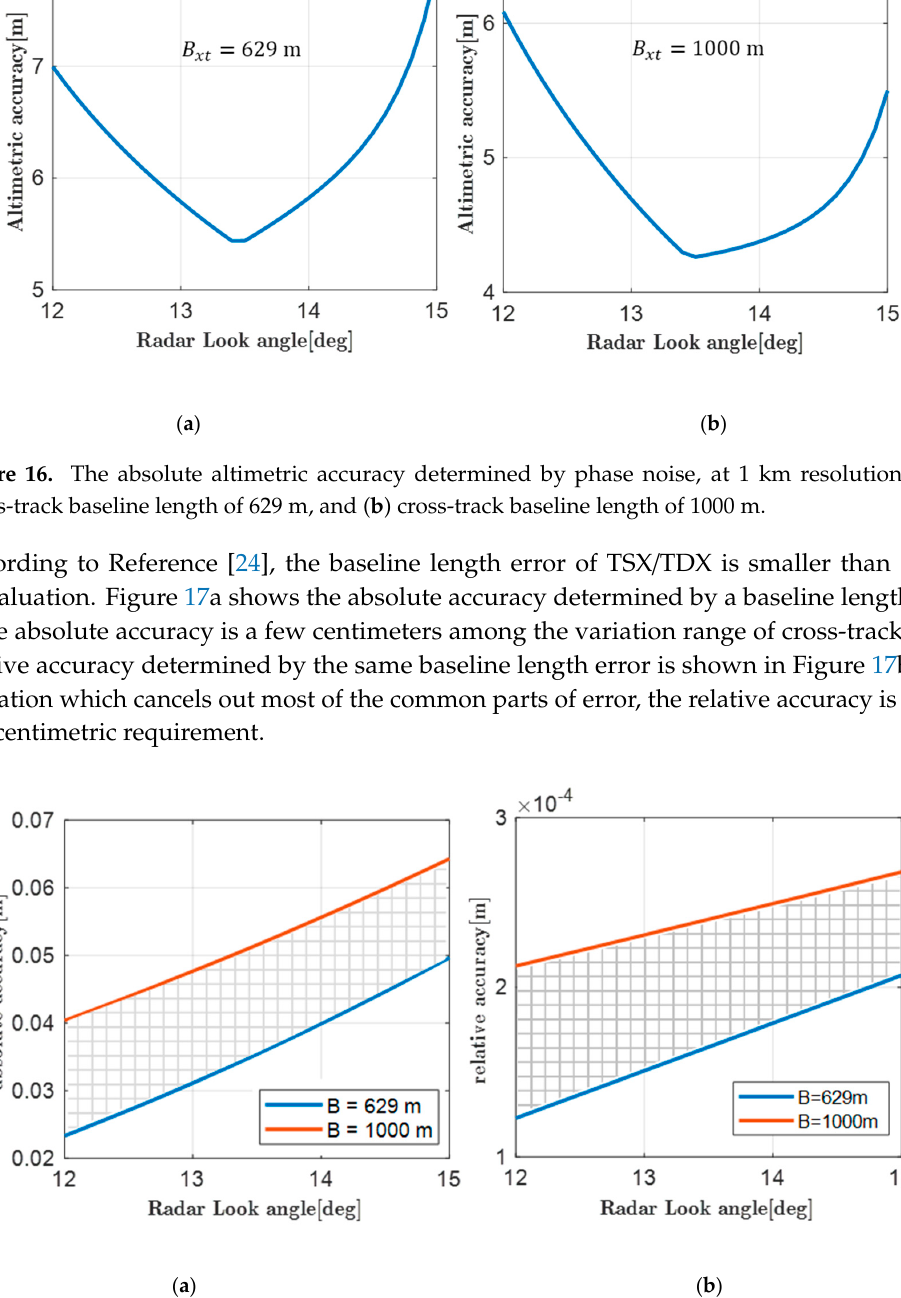
( b ) Figure 18. The altimetric error determined by an equivalent baseline inclination error. ( a ) The absolute accuracy and ( b ) the relative accuracy. Although the relative altimetric accuracy of LB-IRA can be as high as a few millimeters, the absolute accuracy still cannot fulfill the centimetric accuracy requirement at present. The biggest altimetric error comes from the baseline length error, due to limited ranging accuracy between two satellites. If the ranging accuracy can be improved by an order of magnitude by calibration from the ground, or utilizing other advanced ranging techniques, for example, the K-band ranging system on